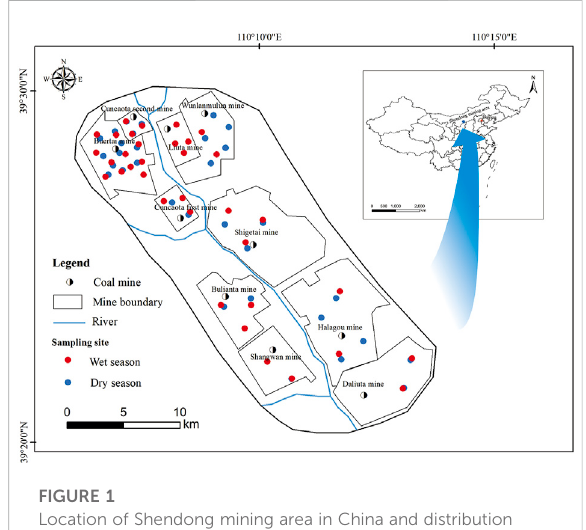
FIGURE 1 Location of Shendong mining area in China and distribution of deep groundwater sampling